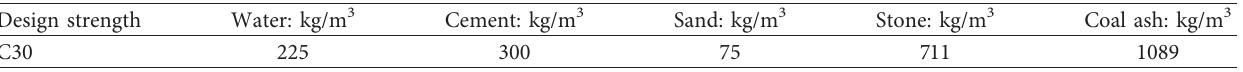
Table 2: Concrete mix.